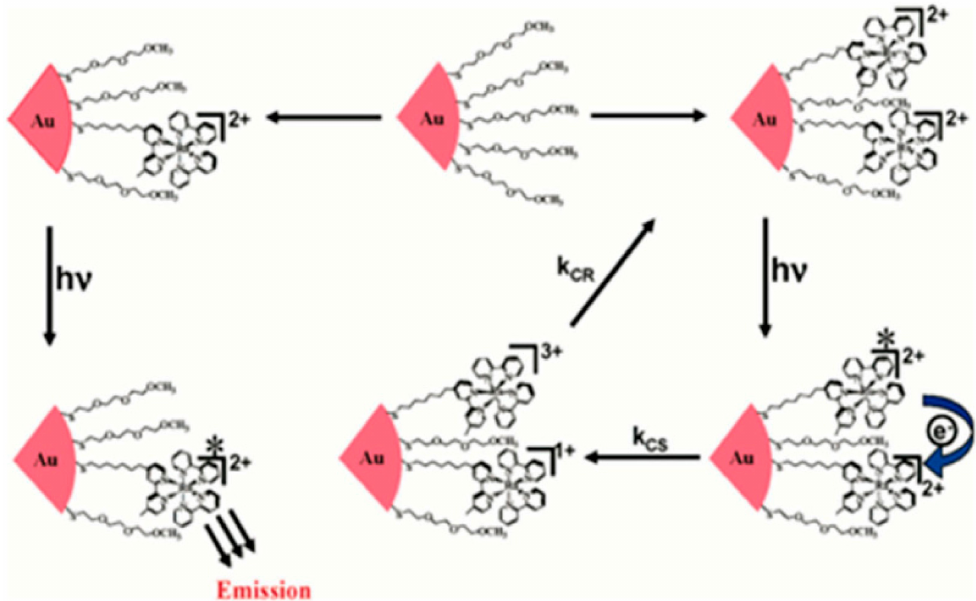
Figure 15. Tris(Bipyridine) assisted the Ru (II) light-inducing process complex of Au NPs, replicated with reference permission, ACS, 2006, within this Au-(S-C7-Ru) method